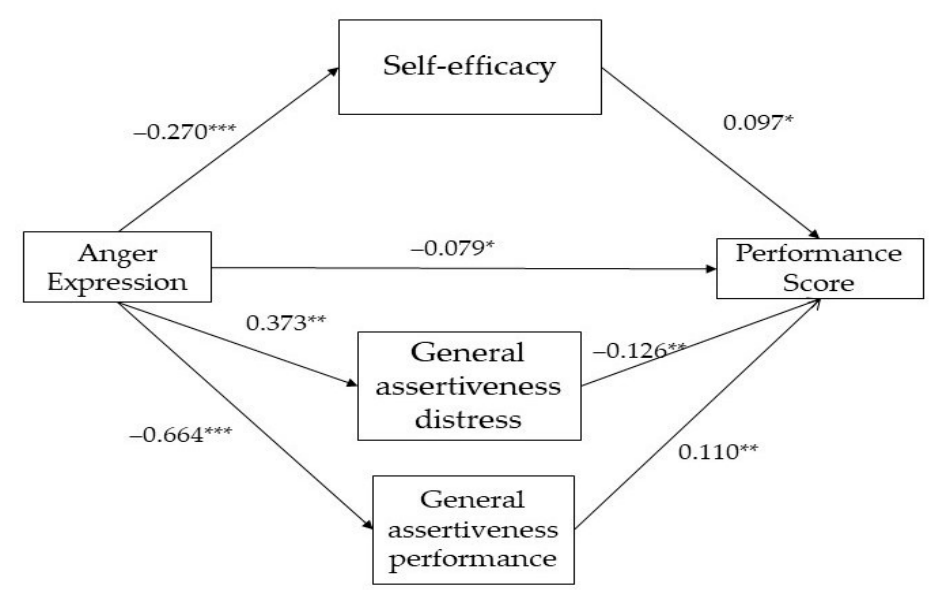
Figure 2. Parallel-multiple mediation of self-efficacy and general assertiveness (distress and per- formance) between anger expression and performance children’s score (group of coaches). Note: * p < 0.05; ** p < 0.01; *** p < 0.001. Dashed lines indicate non-signi fi cant e ff ects.